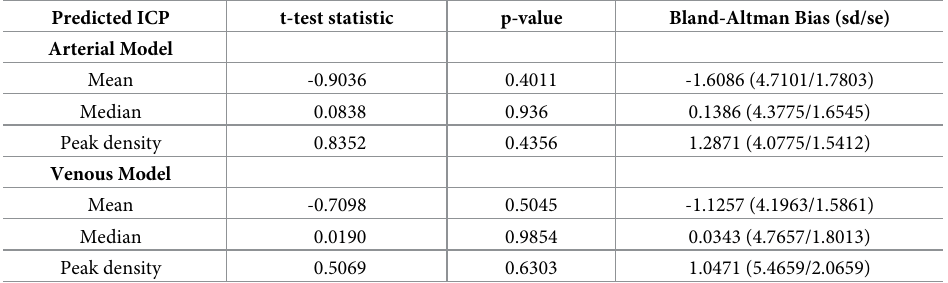
The measured ICP was compared against the mean and peak density of the estimate from both vascular models. The venous median demonstrates the highest agreement with measured intracranial pressure. sd = standard deviation, se = standard error. Bland-Altman plots are displayed in (Figs 11 and